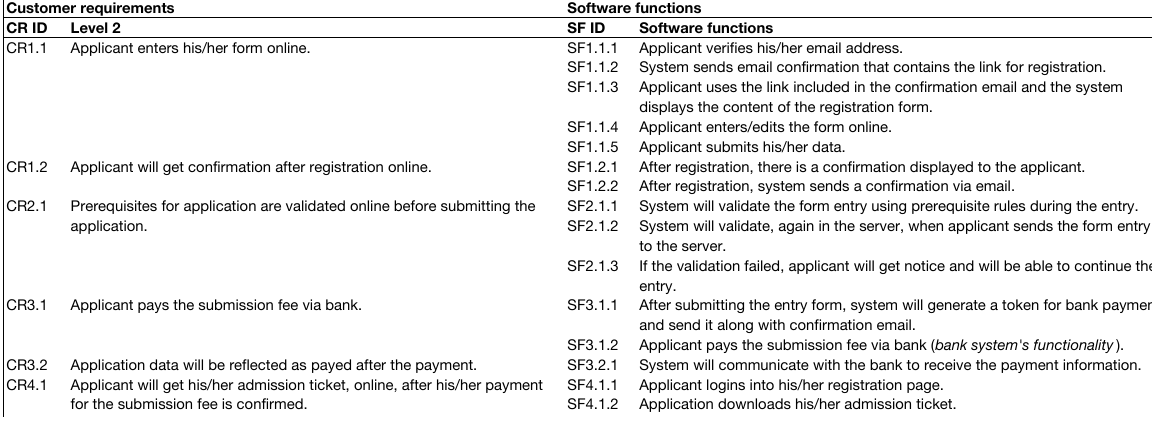
Table 3. Deployment of the software functions from the customer requirements